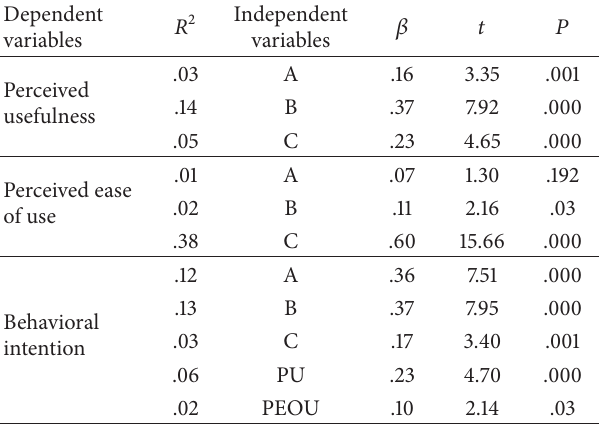
Table 6: Regression analysis for customer’ data.